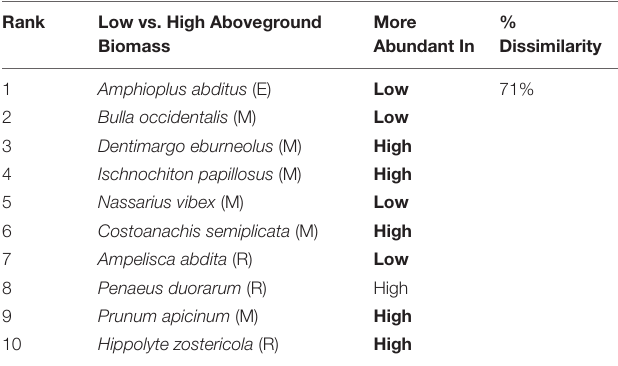
TABLE 4 | Top 10 species contributing to significant differences between community composition among vegetative biomass categories in SIMPER analyses.